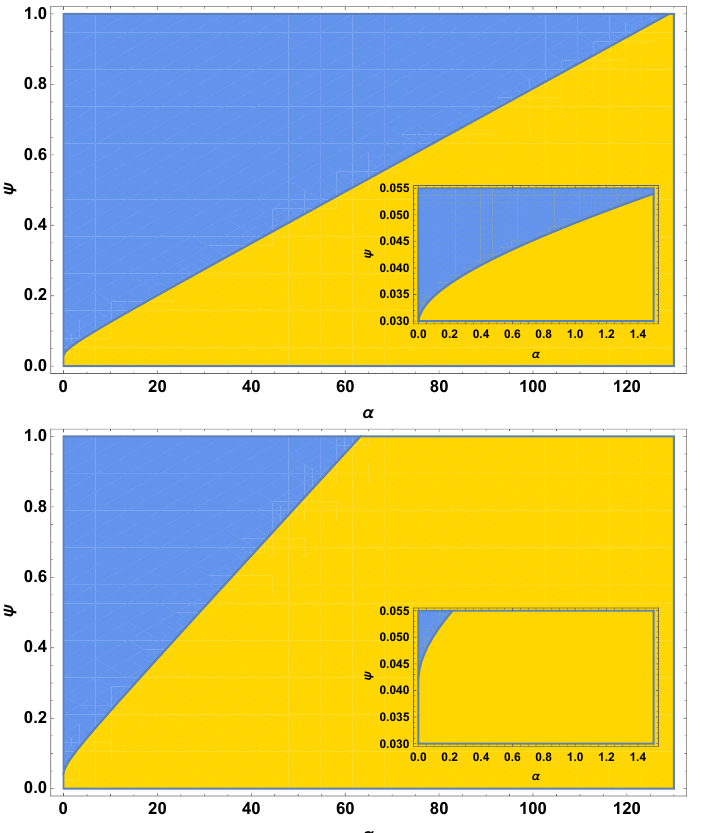
Figure 3. The top figure shows the degenerate hyperbola using “sample value” parameters from Table 1, with λ = 31. The bottom figure uses the same values but with λ = 22. The blue shaded region (top left of each graph) corresponds to stability of the coexistence equilibrium E 3 ; the yellow shaded region (bottom right of each graph) corresponds to stability of the boundary equilibrium E 1 . The insets illustrate the curvature of the hyperbola near the